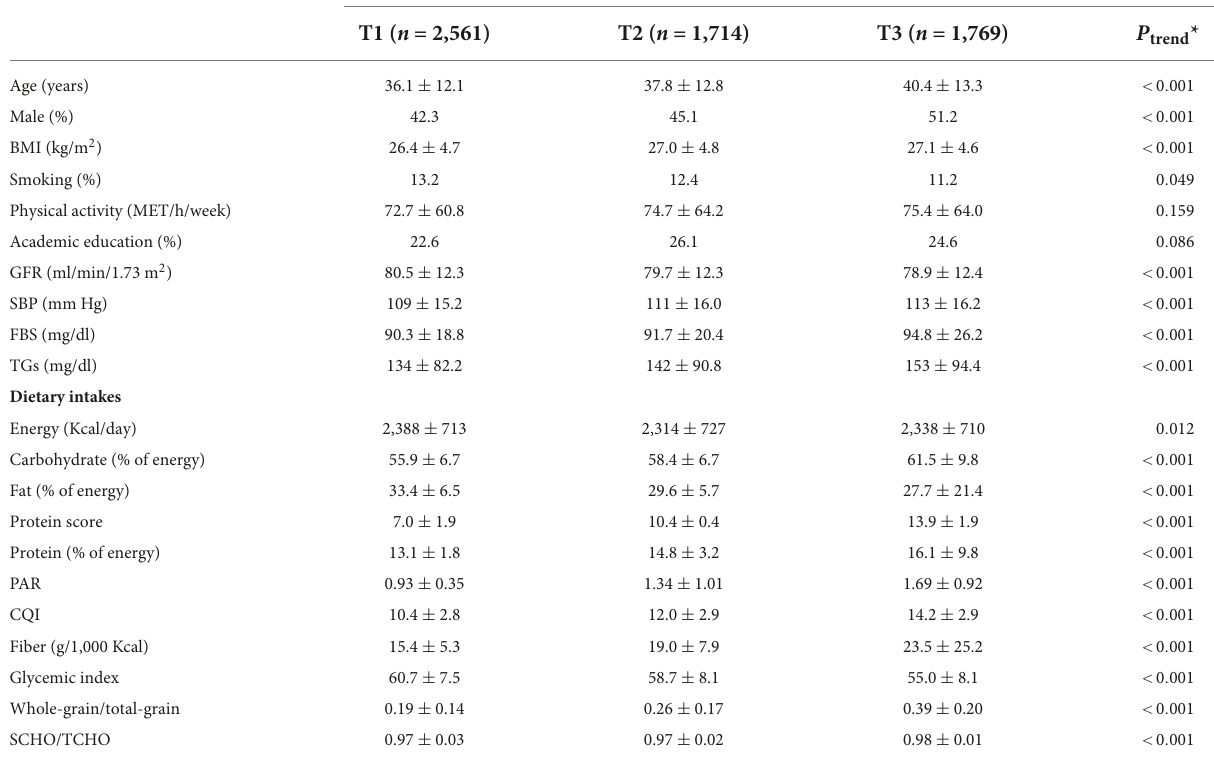
TABLE 1 Baseline characteristics of participants according to tertiles (T) of protein